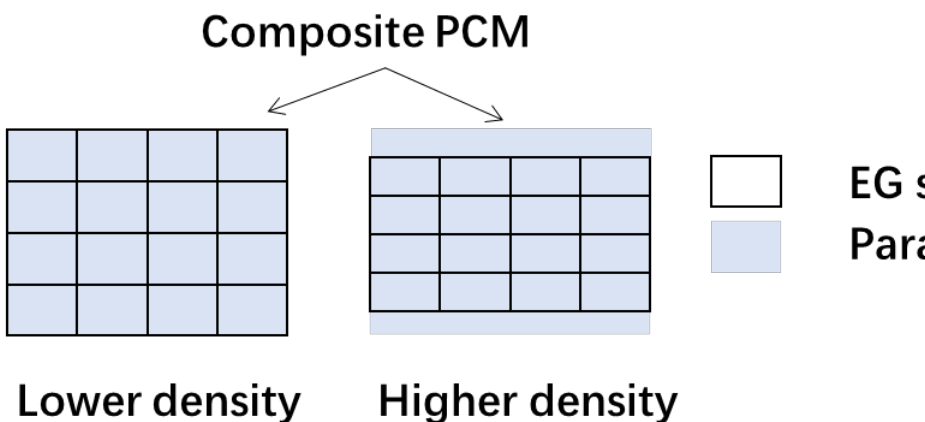
Figure 7. Structure schematic of the composite PCM in different density.